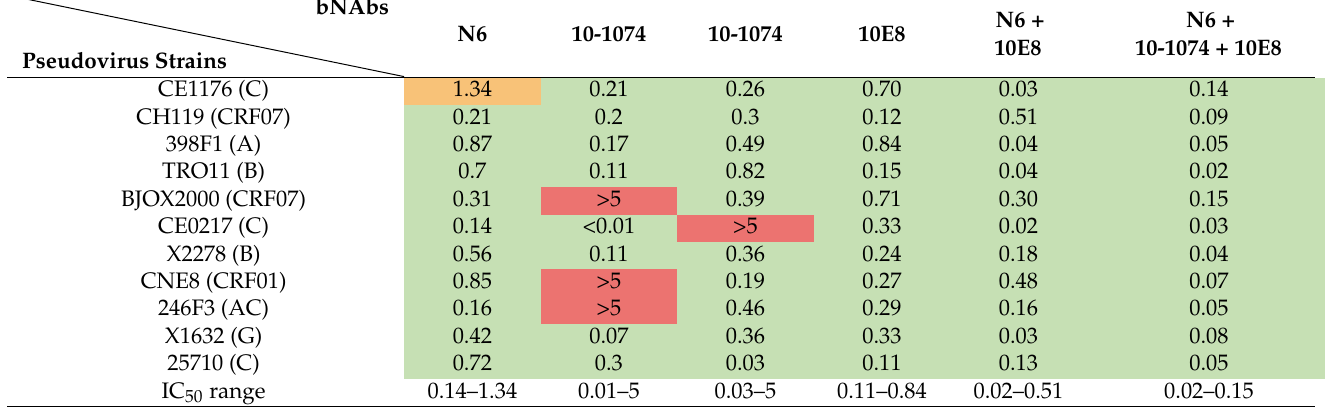
Table 3. IC 80 values for antibodies N6, 10E8, 10-1074, and their combinations.